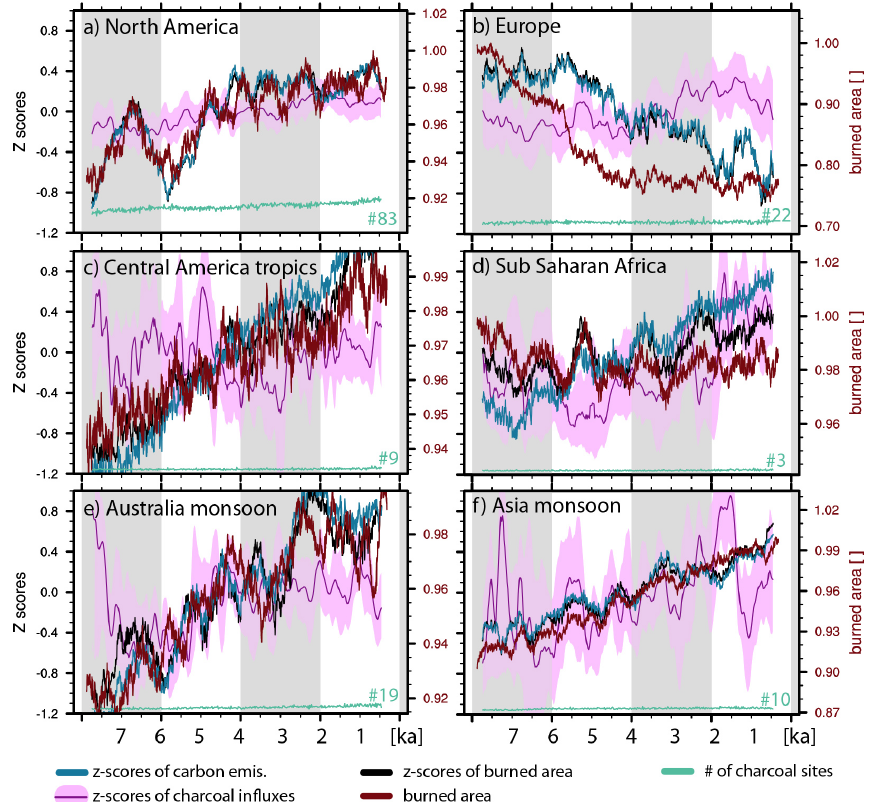
Fig. 4. Same as Fig. 3, but for continental scale regions North America (a) , Europe (b) , Central America tropics (c) , Sub Saharan Africa (d) , Australian monsoon region (e) , and Asia monsoon region (f) . The definition of the domains is taken from Marlon et al. (2013). For the rank c or relations see Fig.